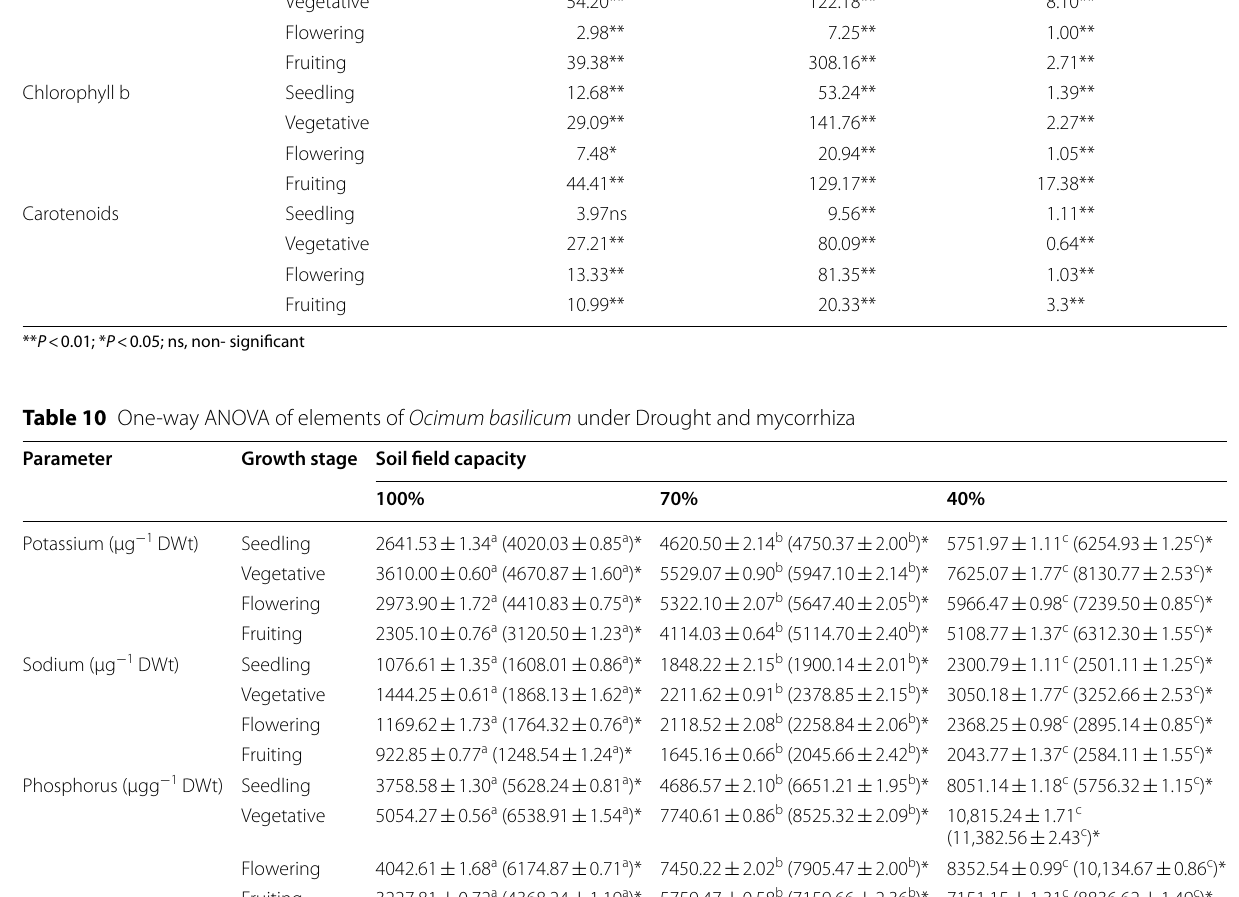
Values of parameters in parentheses correspond to the application of mycorrhiza. Values in a row with different superscript letters are significantly different at P < 0.05. *Significant effect of mycorrhiza application at each soil field capacity at P < 0.05 according to t ‑test. ns : non‑significant effect of mycorrhiza application at each soil field capacity at P < 0.05 according to t-